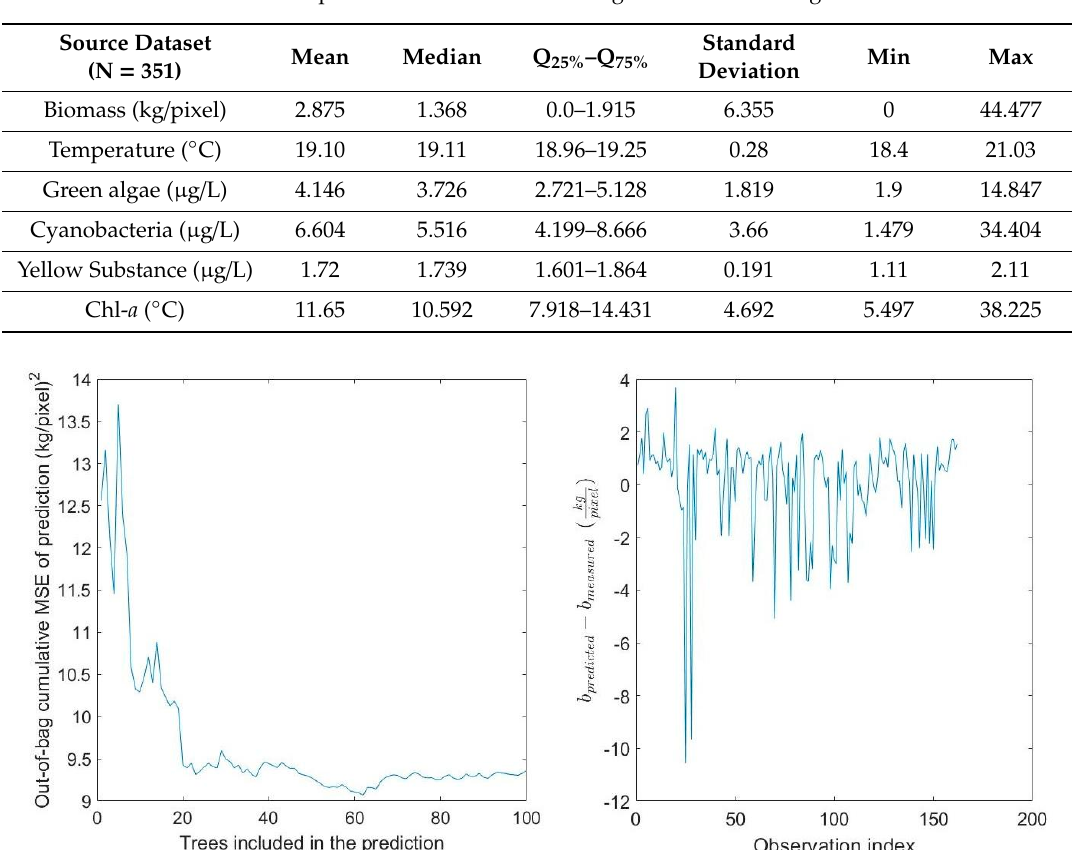
Figure 5. Cumulative mean squared prediction error for the out-of-bag biomass density values of the training dataset for the Landsat-5-trained regression tree ensemble. Error of prediction on the training dataset observations for the Landsat-5-trained regression tree ensemble.